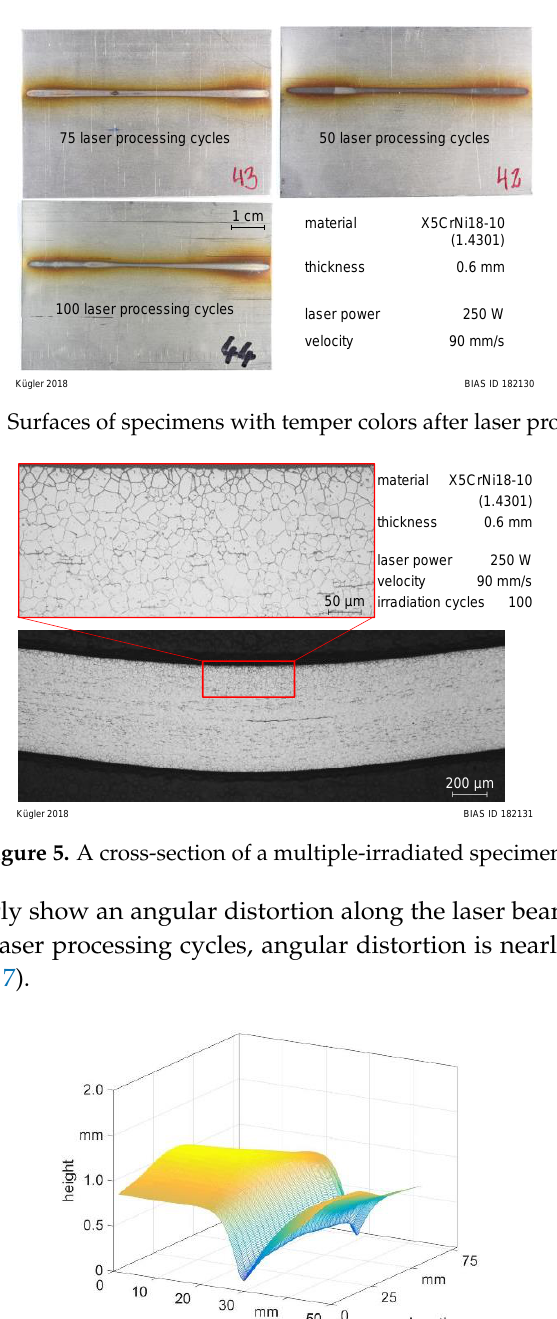
Figure 7. Angular distortion after laser processing. When analyzing roughness values, it can be shown that surfaces become rougher via increasing laser processing cycles (Figure 8). Mean values such as Sa and Sq stay rather constant for up to 20 processing cycles and increase with higher amounts of processing cycles. However, maximum surface height Sz increases already with 10 processing cycles.